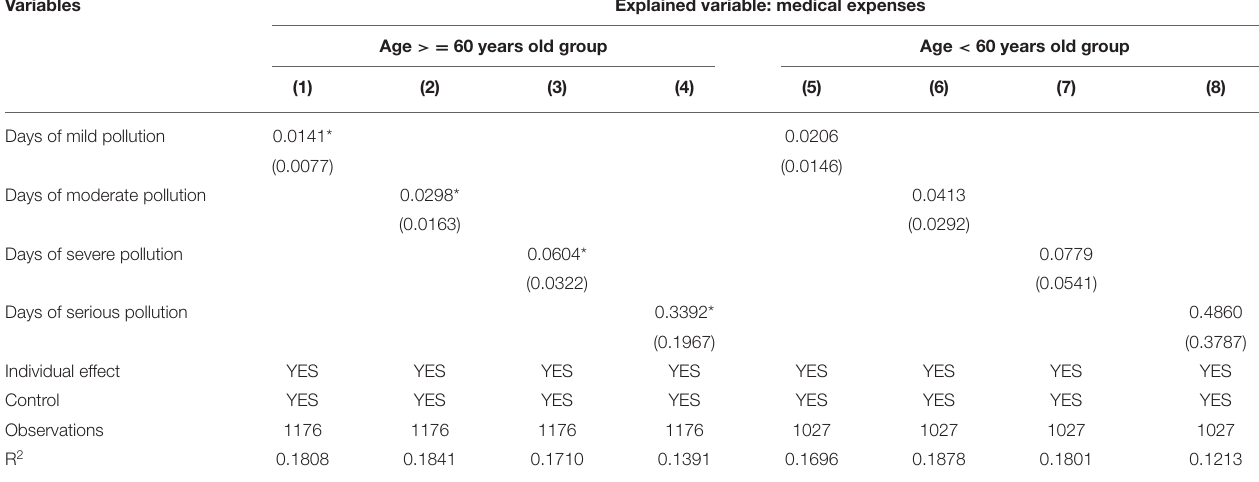
TABLE 5 | Age heterogeneity: air pollution and medical